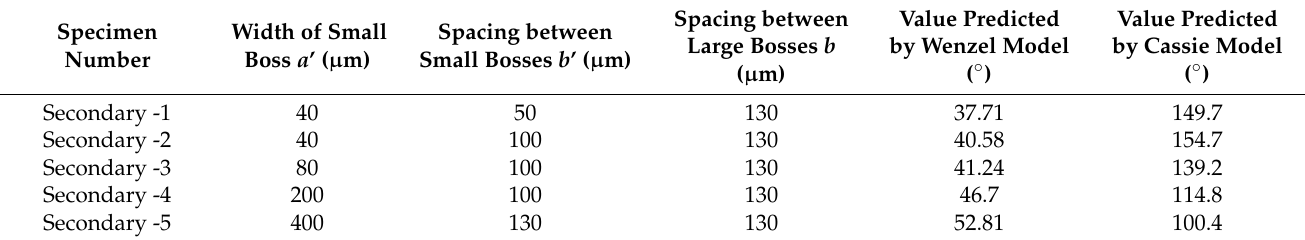
Table 3. Dimension parameters for the design of cruciform secondary